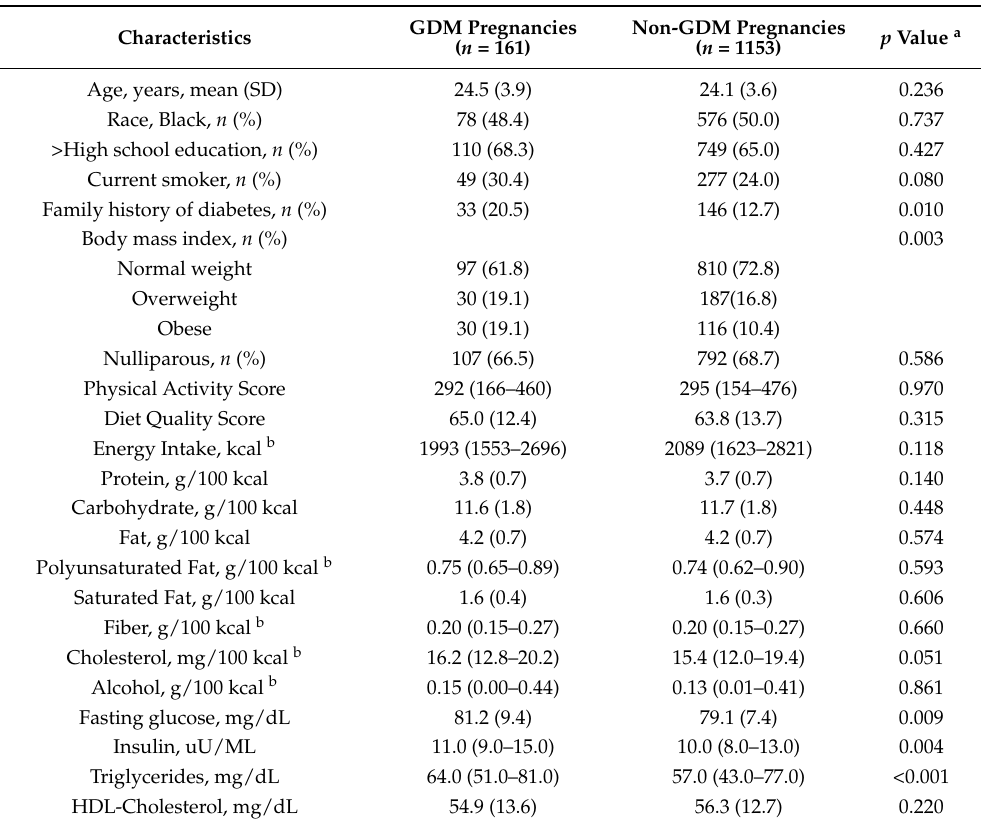
Table 1. Diet Quality Cohort. Participant characteristics at baseline (Year 0) by subsequent GDM pregnancy status, the CARDIA study ( n = 1314),